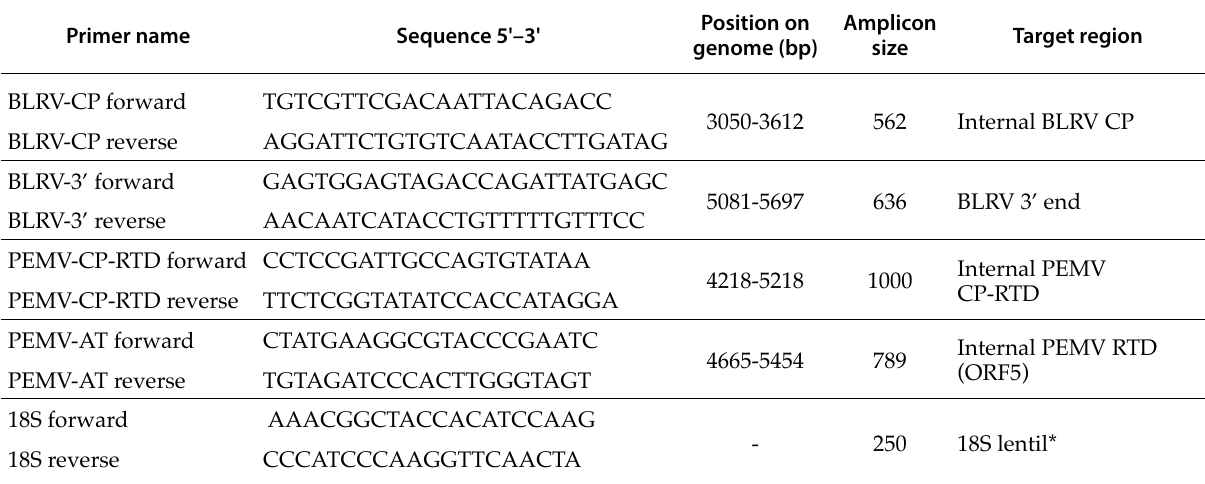
Table 2. Sequences of primers used in PCRs for the detection and characterization of Greek lentil isolates of Bean leafroll virus (BLRV) and Pea enation mosaic virus